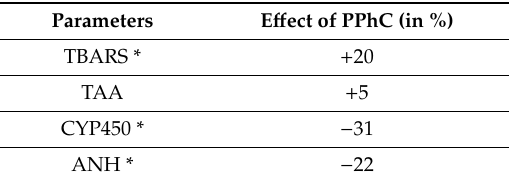
Table 2. Di ff erences (in %) between the average scores of the main parameters of oxidative stress (TBARS and TAA) and drug metabolism (CYP450 content and aniline hydroxylase, ANH) achieved in animals treated with PPhC (* p < 0.05) vs. healthy untreated animals used as a control group (100%).